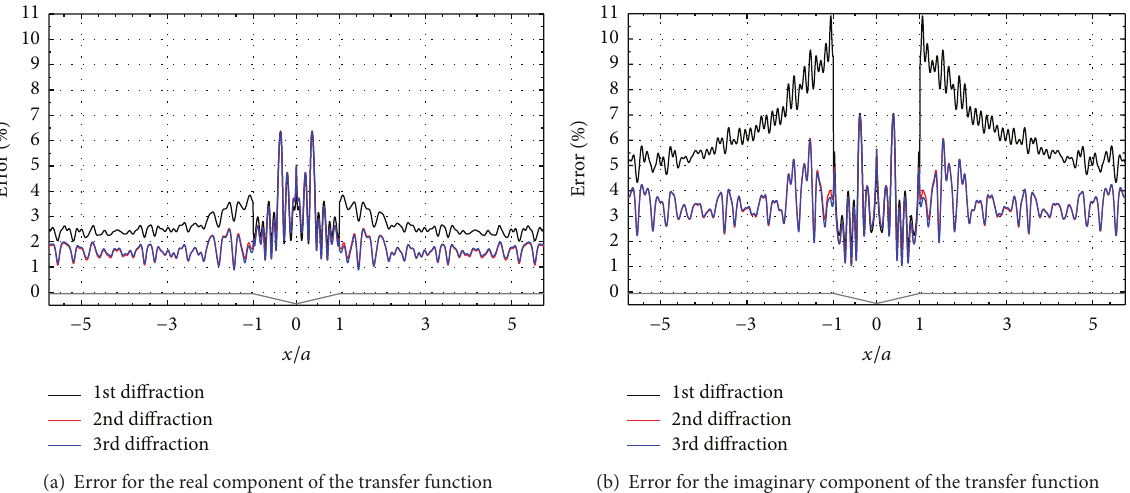
Figure 12: Error measures for the real and imaginary parts of the transfer function obtained with the BEM and the SBD